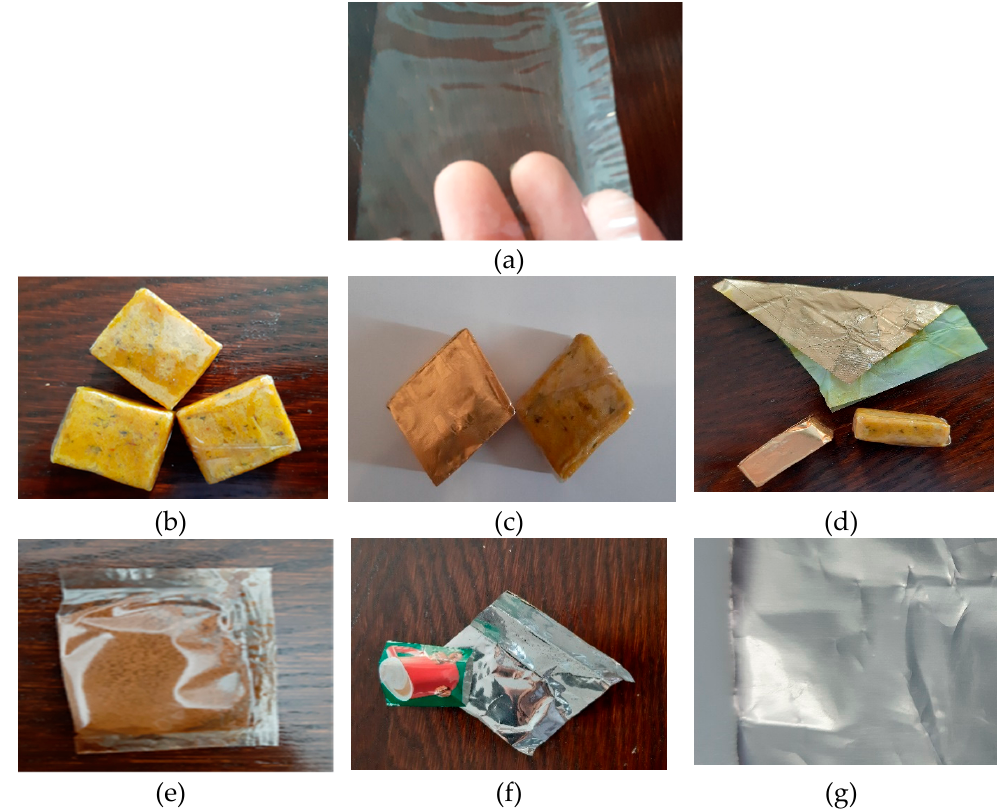
Figure 2. Applications of edible films. Replacement of conventional multilayer packaging with edible materials. ( a ) Film enriched with inulin (I17), ( b ) dehydrated vegetables packed in edible foil, ( c , d ) di ff erences between conventional packaging and new packaging, ( e ) soluble co ff ee packed in edible foil, ( f , g ) metal foil used for soluble co ff ee